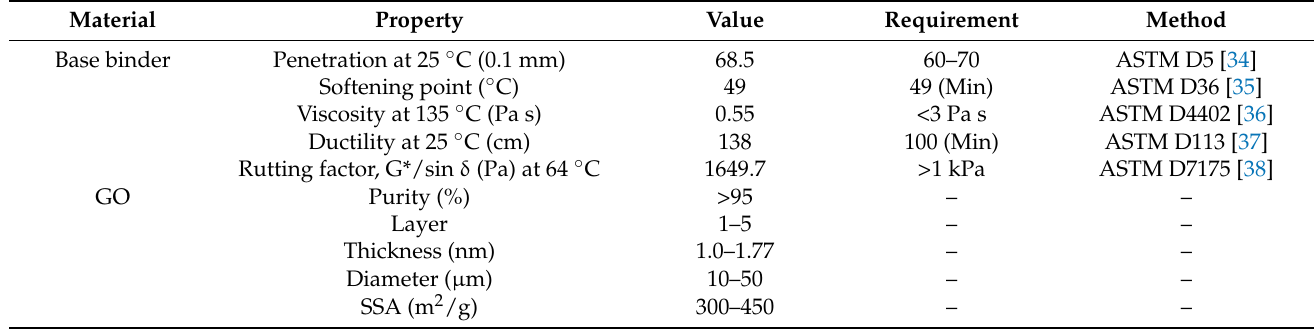
Table 1. Characteristic properties of the base binder and